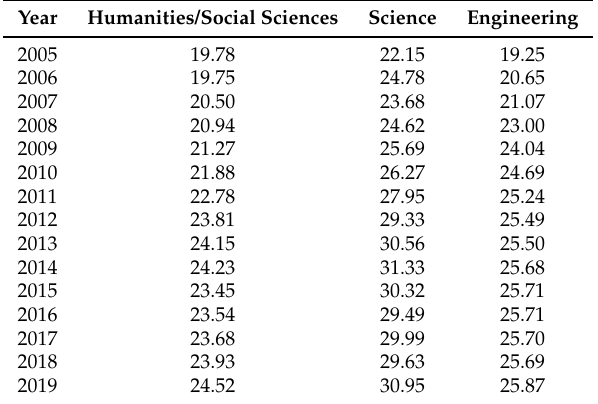
Table 4. Proportions (%) of core collections according to the affiliations of users.